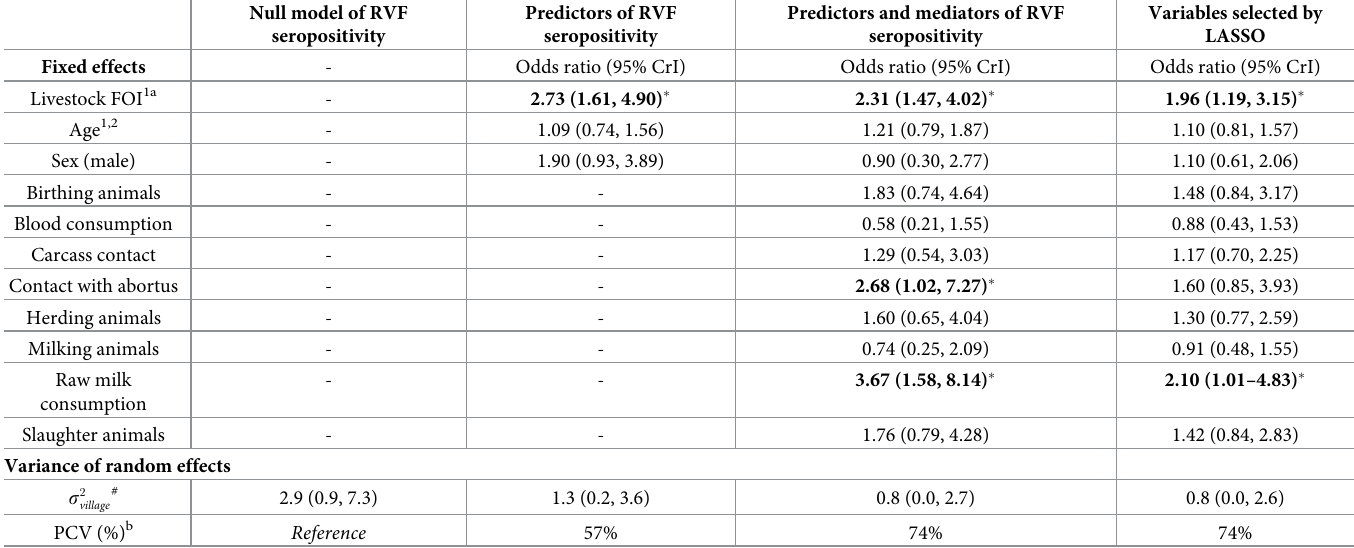
Table 3. Parameter estimates from logistic regression analysis of Rift Valley fever virus seropositivity in humans in northern Tanzania using 533 samples collected from 2013 through